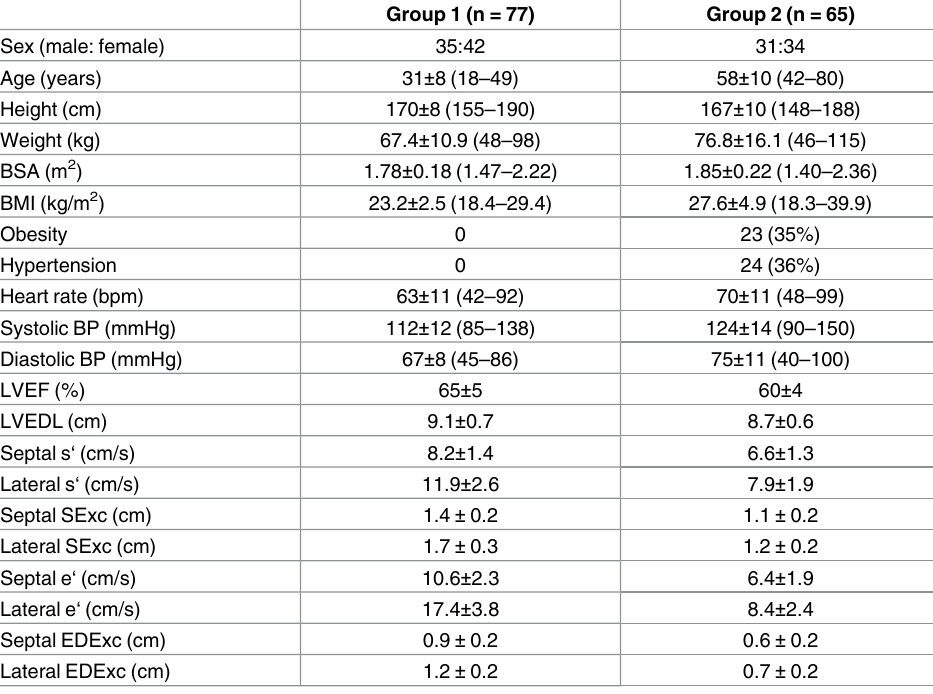
Table 1. Clinical and echocardiographic characteristics of the study